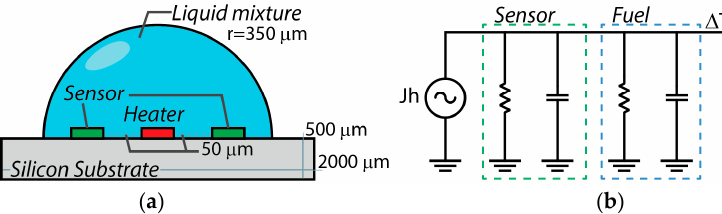
Figure 1. ( a ) Cross section of the structure: a p-type polysilicon strip (red block) is used as both heater and resistive temperature sensor, while another two polysilicon strips (light yellow blocks) at a well-defined spacing from the heater is used to enable temperature difference sensing and ( b ) electrical analogy of the thermal system.